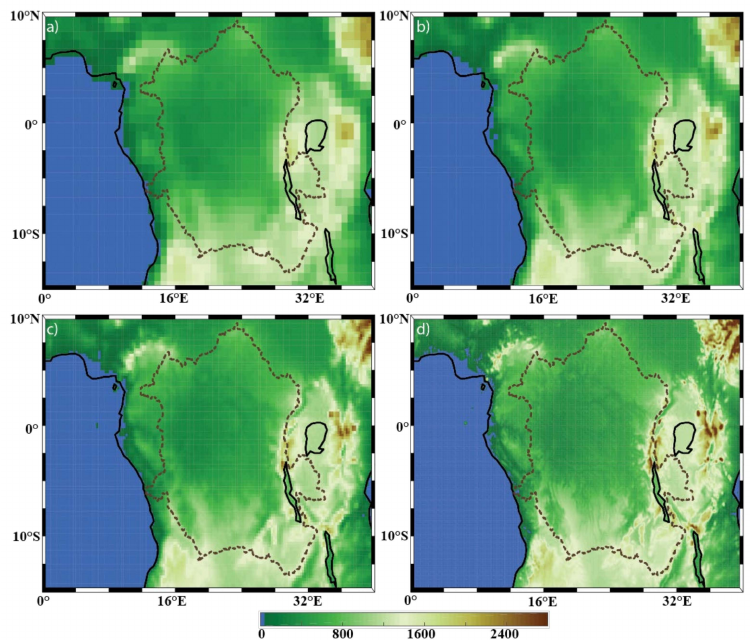
Figure 2. Topography (measured in meters, m) of the DRC region with the Congo Basin outlined with the dotted lines, derived from ( a ) ERA-I, ( b ) eERA5, ( c ) ERA5, and ( d ) ECOA,